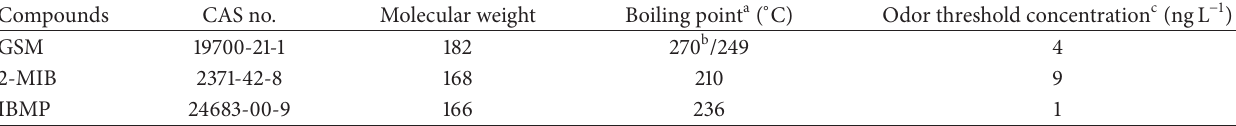
Table 1: The CAS number, molecular weight, boiling point, and odor threshold of the three compounds.